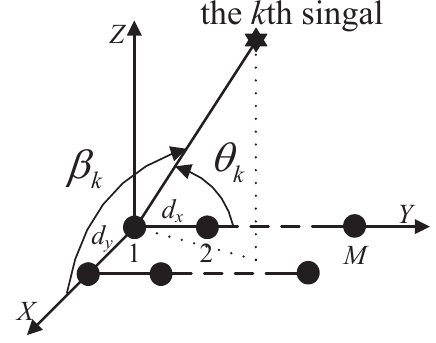
Figure 1. The geometry configuration of the